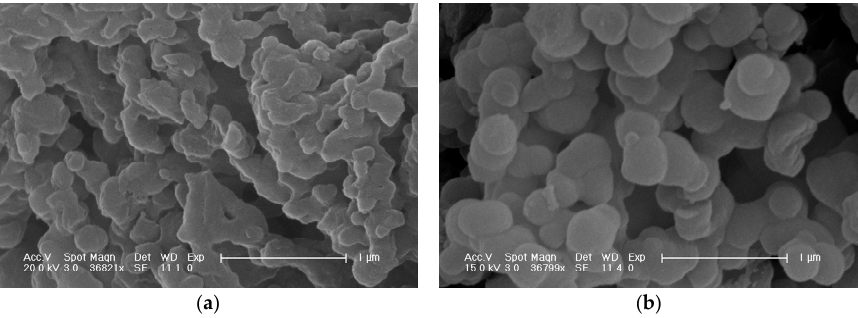
Figure 3. Scanning electron microscope (SEM) images of NH 2 -Silica ( a ) and co-immobilised enzymes ( b ).